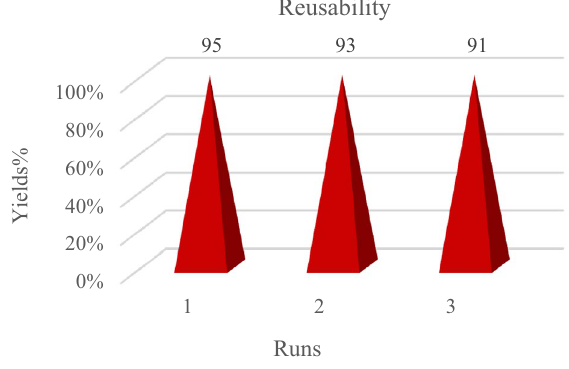
Figure 11. Reusability of FNASiPPEA for the synthesis of DHPC.